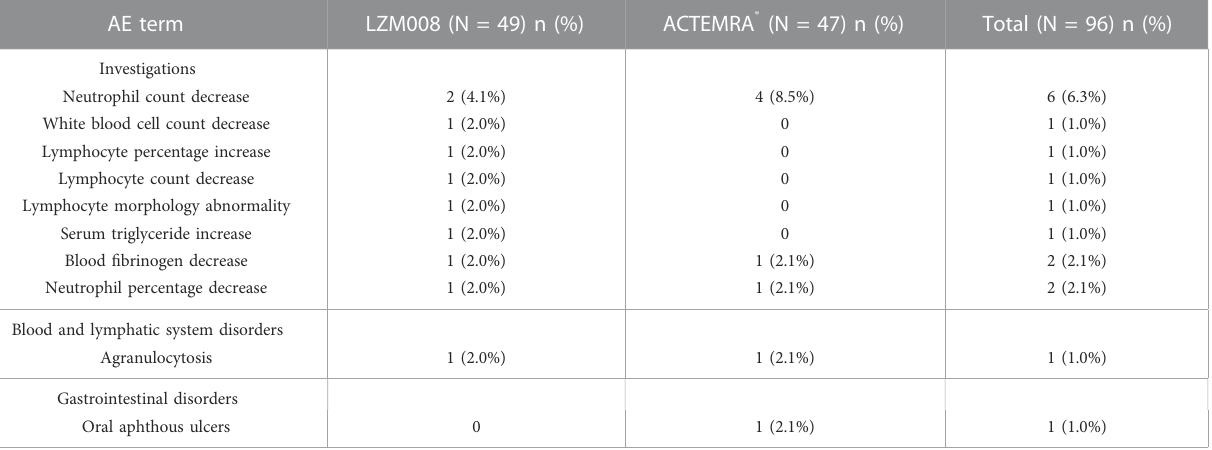
TABLE 5 TEAEs in grade III or higher of LZM008 and ACTEMRA ®